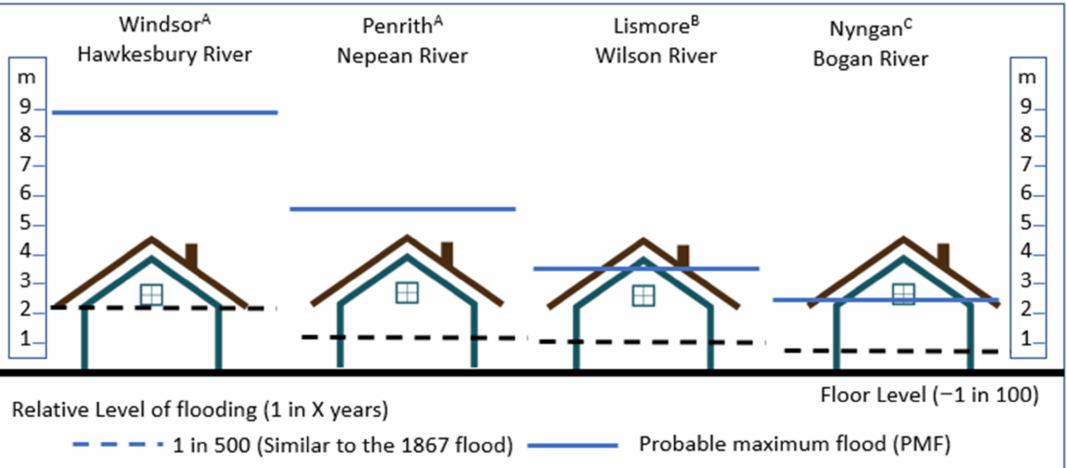
Figure 2. Comparison of the differences in flood levels and flood risk between the Hawkesbury- Nepean River and other